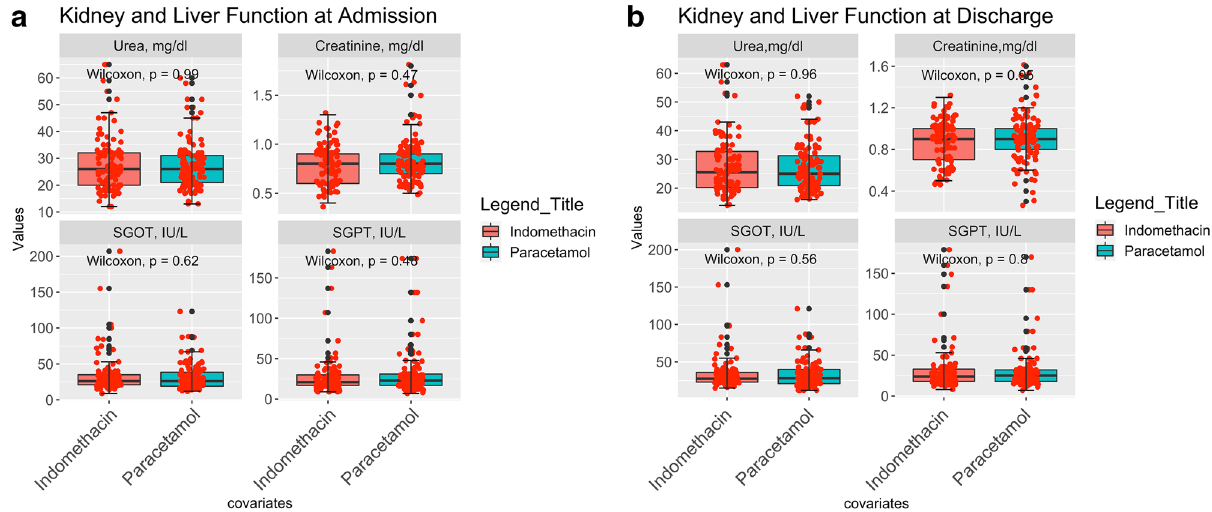
Figure 7. ( a ) Kidney and liver function test on admission. ( b ) Kidney and liver function test on